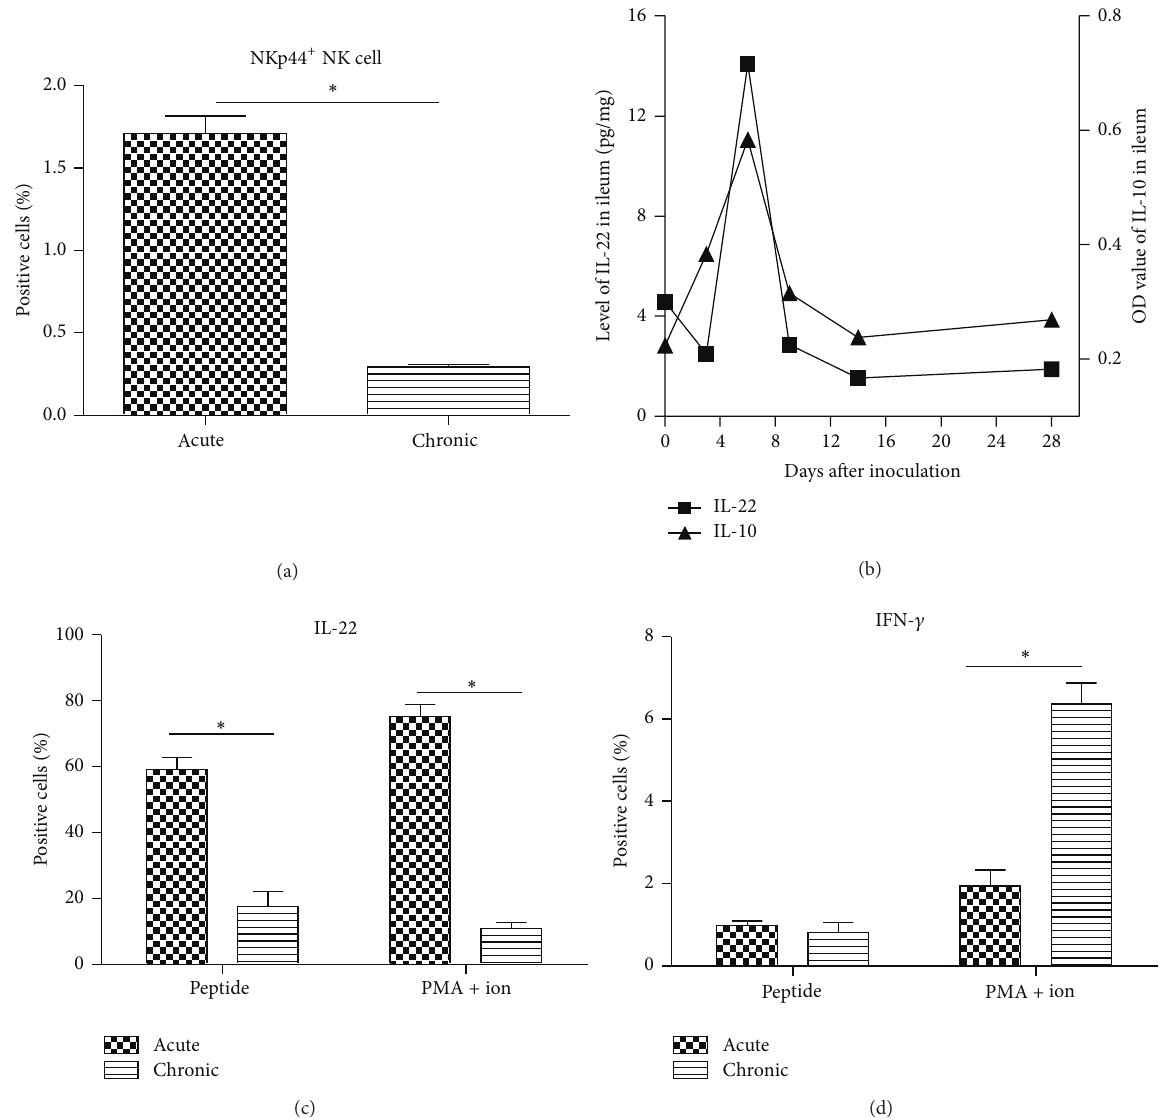
Figure 5: Number and cytolytic function of mucosal natural killer (NK)p44 + NK cells during early acute and chronic phases of simian immunodeficiency virus (SIV) infection. (a) Frequency of NKp44 + NK cells at early acute and chronic phases of SIV infection. (b) Levels of IL-22 and IL-10 in ileum of monkeys infected with SIV during the early acute phase. (c) IL-22 secretion and (d) IFN- 𝛾 secretion of mucosal NKp44 + NK cells stimulated with peptide or phorbol 12-myristate 13-acetate (PMA) + ionomycin. The column bar indicates the mean of the ratio of target cells (mononuclear cells in (a); NKp44 + NK cells in (c) and (d)). Error bars and individual standard deviations (SD) are shown. ∗ 𝑃 ≤ 0.05 as calculated by two-sided nonparametric Mann-Whitney 𝑈